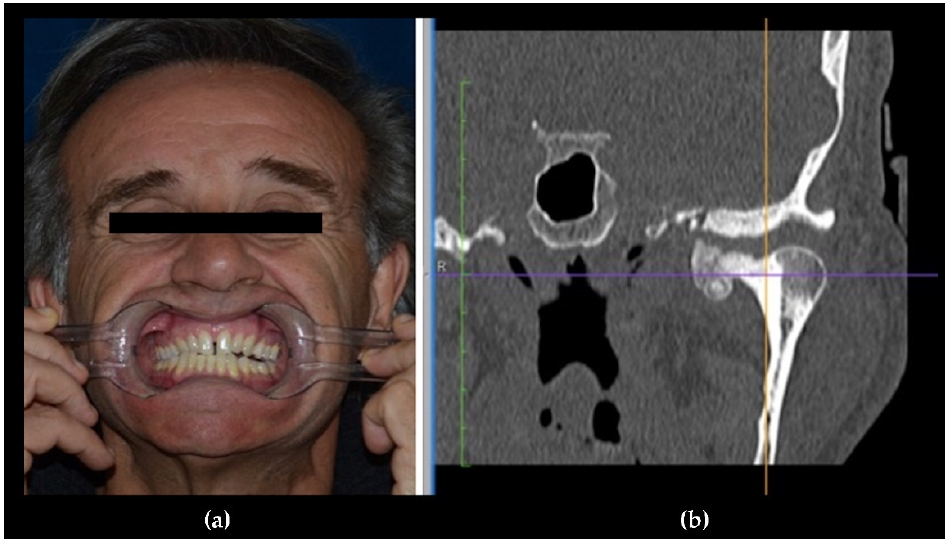
Figure 7. ( a ) A male patient with dental malocclusion, characterized by left open bite and right cross-bite; ( b ) CT scan shows a left condylar osteoma.